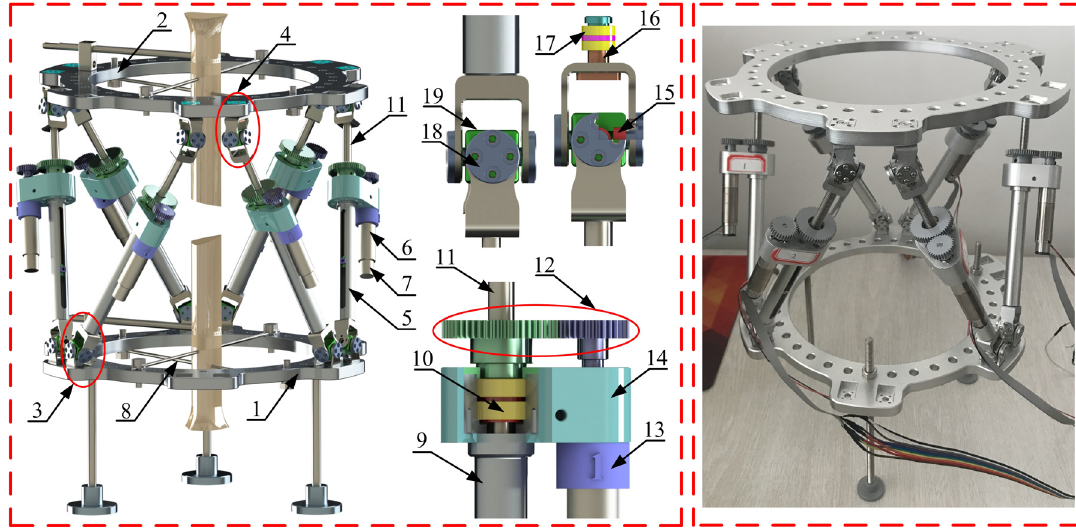
Figure 3. The mechanical diagram of the external fixator. The external fixator consists of (1) proximal ring, (2) distal ring, (3) Hooke joint, (4) spherical hinge, (5) telescopic rod, (6) DC) servo motor, (7) incremental encoder, (8) Kirschner wire, (9) the holder of the telescopic rod, (10) rolling bearing mounted on the screw nut, (11) lead screw, (12) gear reduction, (13) mark number of rod, (14) motor bracket, (15) rolling bearing mounted on the spherical joint, (16) bracket of the spherical joint, (17) bush bearing, (18) end cap, (19) linkage shaft of the Hooke joint.